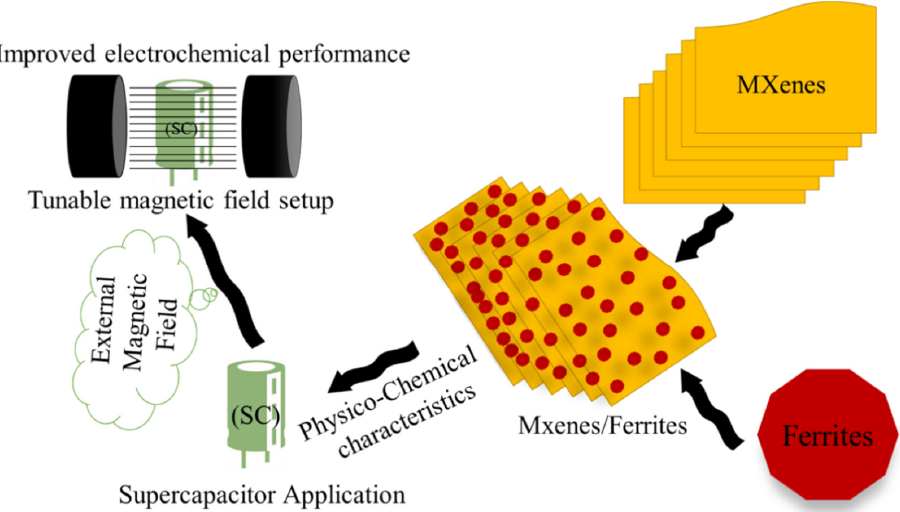
Figure 20. Schematic process diagram for the magnetic field assisted supercapacitor application with MXene/Ferrite magnetic nanocomposites.